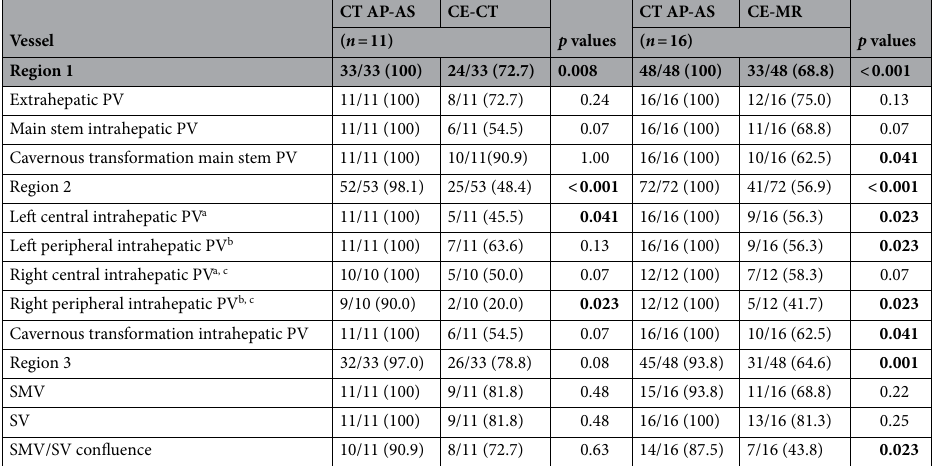
Table 1. Diagnostic capability CT AP–AS versus CE-CT and CT AP–AS versus CR-MR (frequency of confident characterization per imaging modality and vessel). Values are number of studies, numbers in parentheses are percentages. p values are written in bold when statistically significant. a contrast enhancement within the right/left PV to first branching. b contrast enhancement within the expected course of the first order intrahepatic left/rigth PV extending peripherally. c n = 1 and n = 4 patients after split-liver transplantation in the CE-CT group and CE-MR group